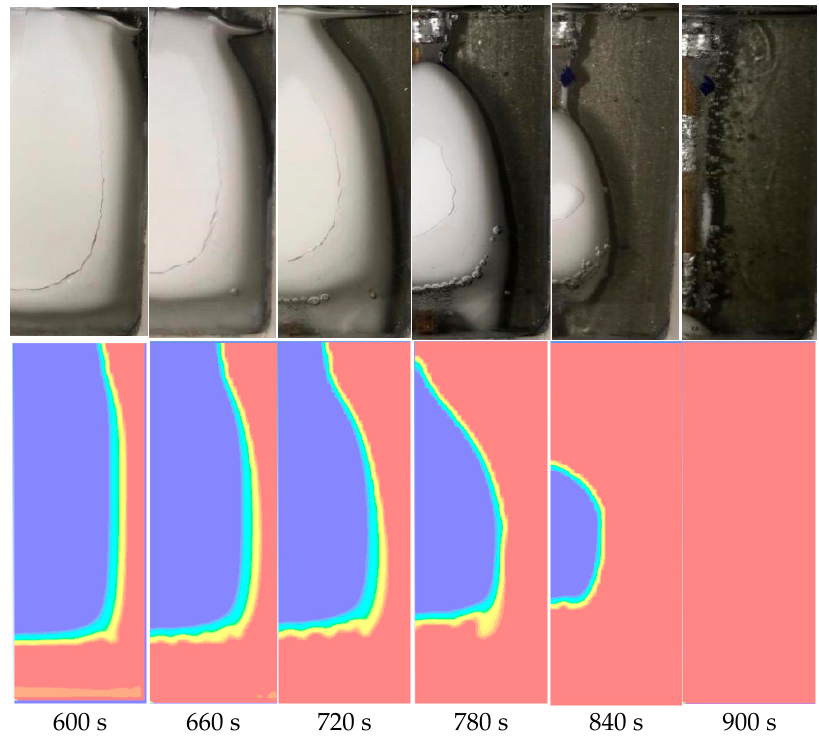
Figure 9. Experimental and simulated results of the melting pure paraffin.